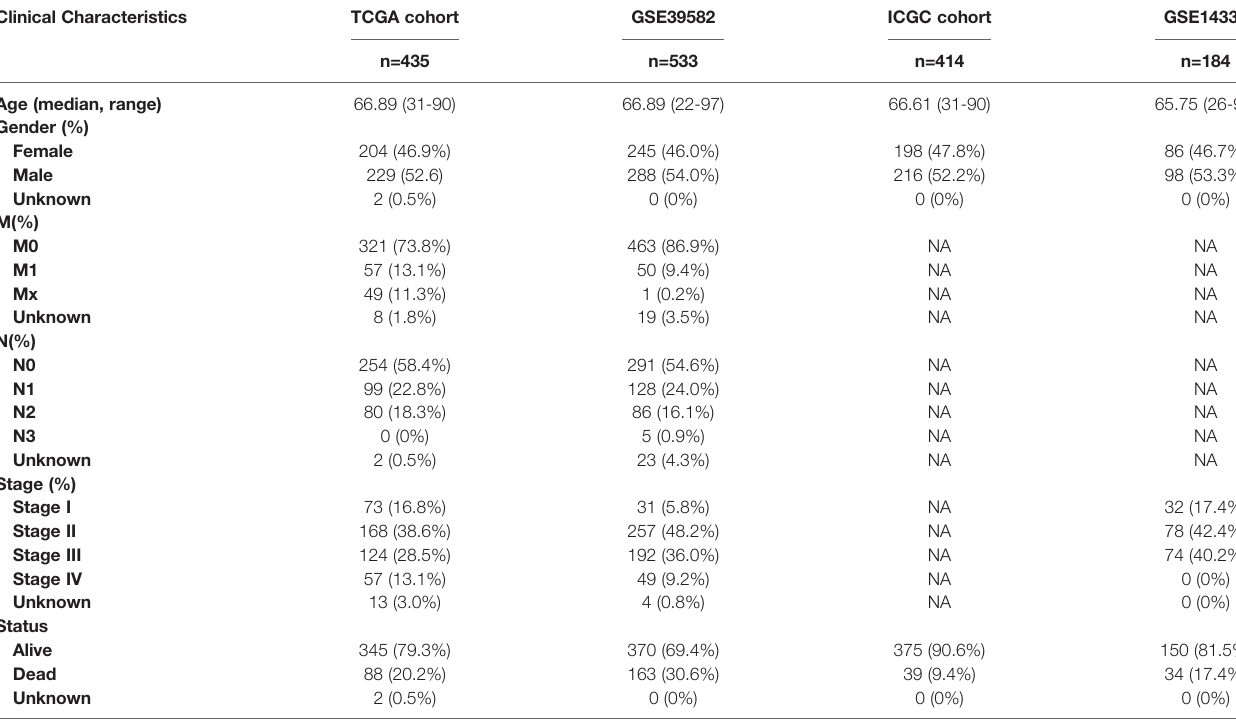
TABLE 1 | The baseline characteristics of CRC patients in the multiple